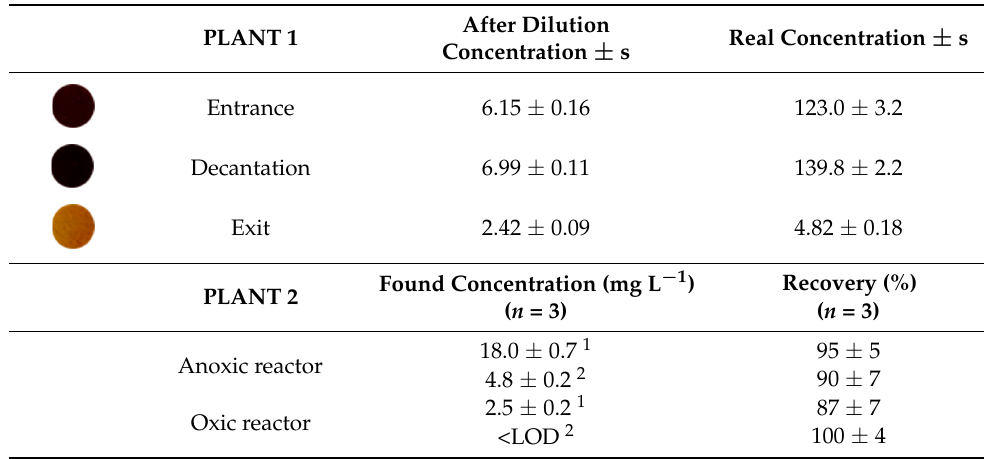
Table 3. Colorimetric sensor response and found concentration from the entrance, decantation, and exit stages from water treatment plant 1 and anoxic and oxic reactors from water treatment plant 2. Sensor images from the different stages of a water treatment plant.